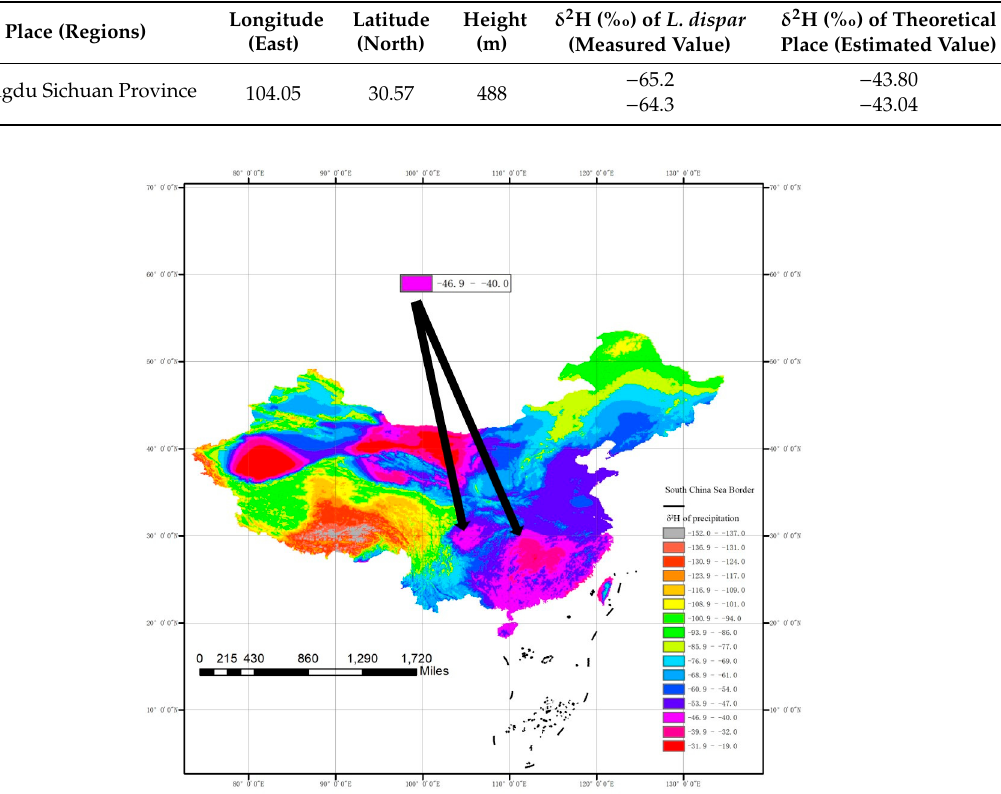
Figure 3. Traceability result indication.